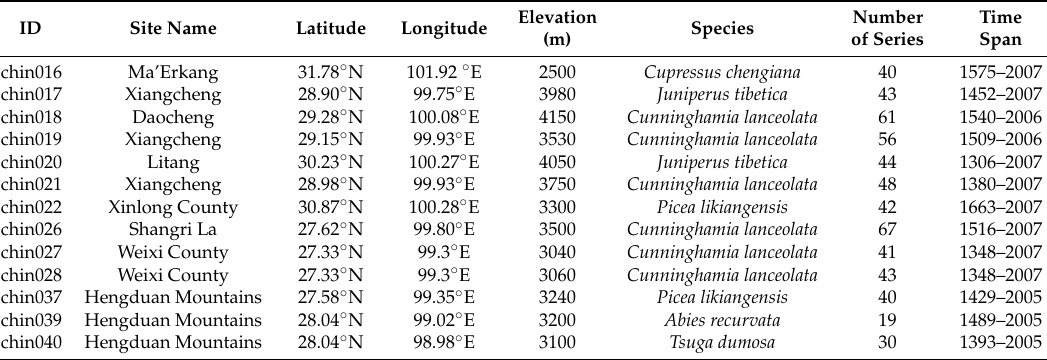
Table 2. Summary of tree ‐ ring samples.